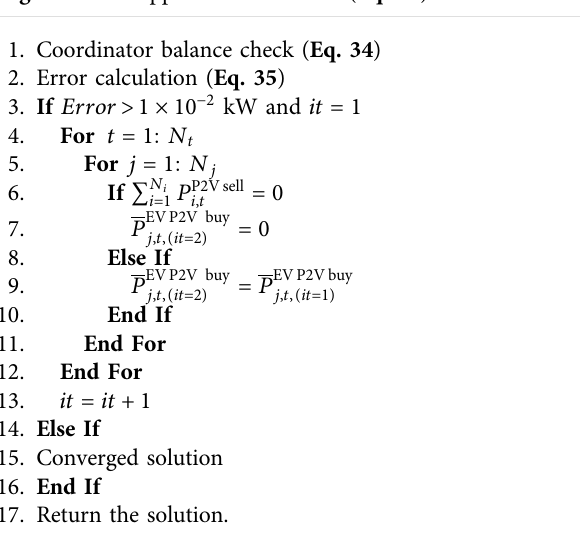
Algorithm 1. Application of Rule 1 ( Eq. 36